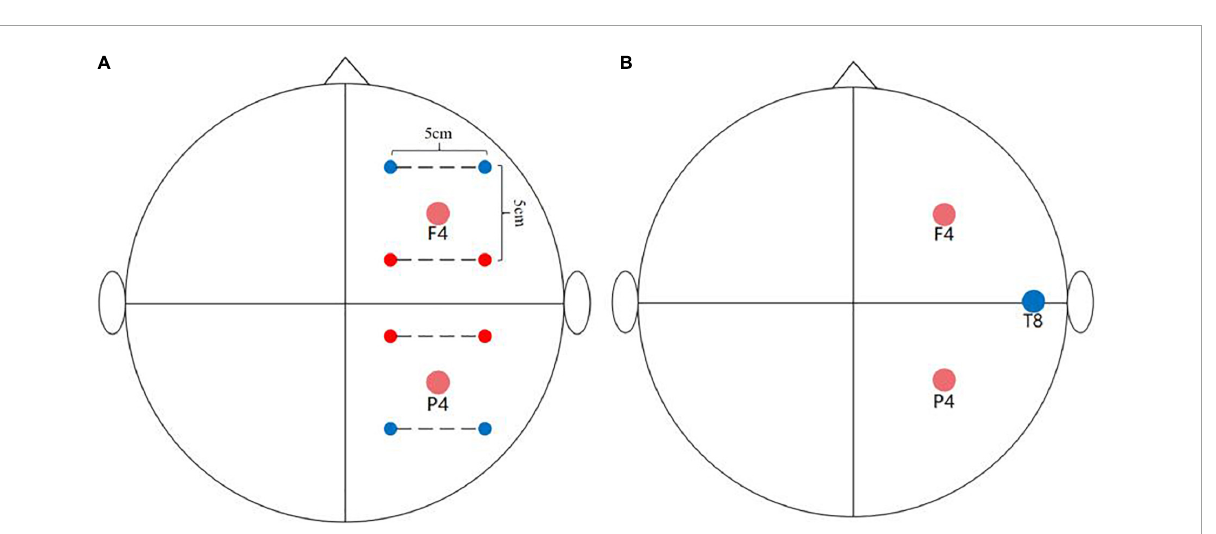
FIGURE2 Stimulation montage. (A) TI stimulation montage: The two red dots and two blue dots are connected by the dotted line representing the alternating currents of 2,000 and 2,006 Hz, respectively. The distance between the center of each electrode was 5 cm. (B) tACS stimulation montage. The two red dots represent the position of the two stimulation electrodes and the blue dot represents the position of the return